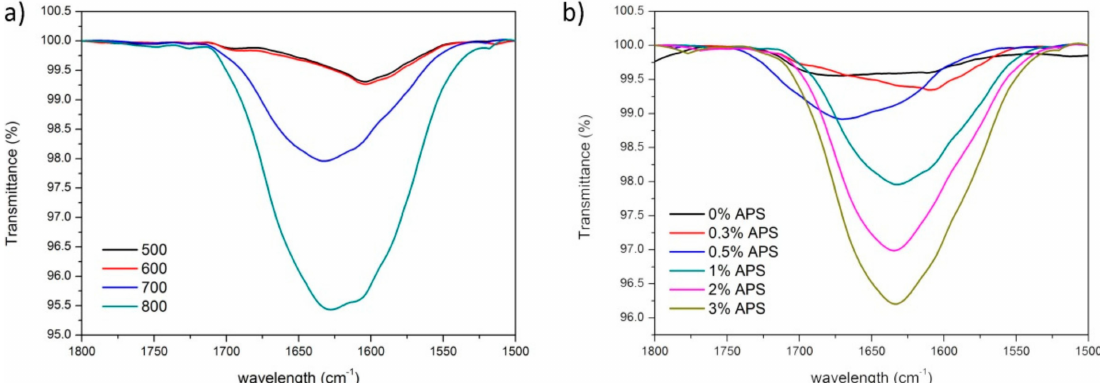
Figure 5. FTIR ATR spectra of the tenofovir (TFV) loaded particles ( a ) containing 1% silane in solution and pyrolyzed at di ff erent temperatures and ( b ) functionalized with di ff erent amounts of γ -APS and pyrolyzed at 700 ◦